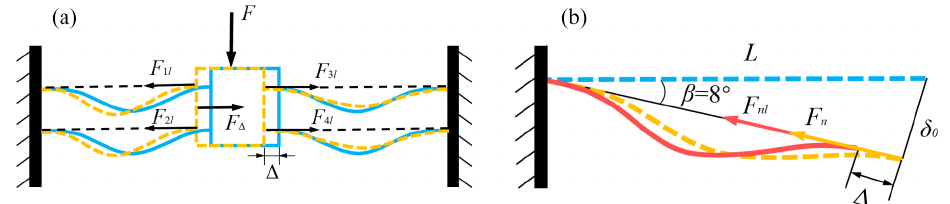
Figure 4. (a) The relationship of in-plane lateral force and deformation of the conventional bistable mechanism at the unstable equilibrium point. (b) The external force and deformation of each fixed-guided beam of the bistable mechanism with in-plane lateral deviation at the unstable equilibrium point.